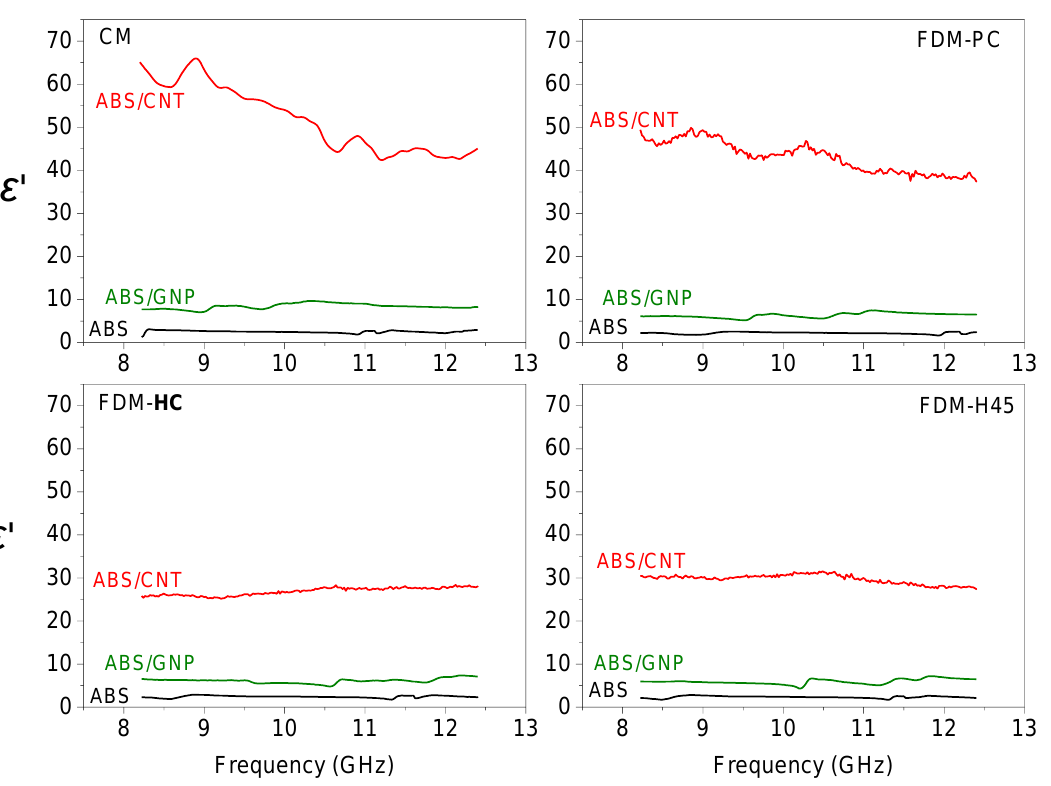
Figure 12. Dielectric constant of ABS and its composites in the X-band frequency range; FDM-PC; FDM-HC; FDM-H45. The orientations PC, HC and H45 are described in Figure 2.